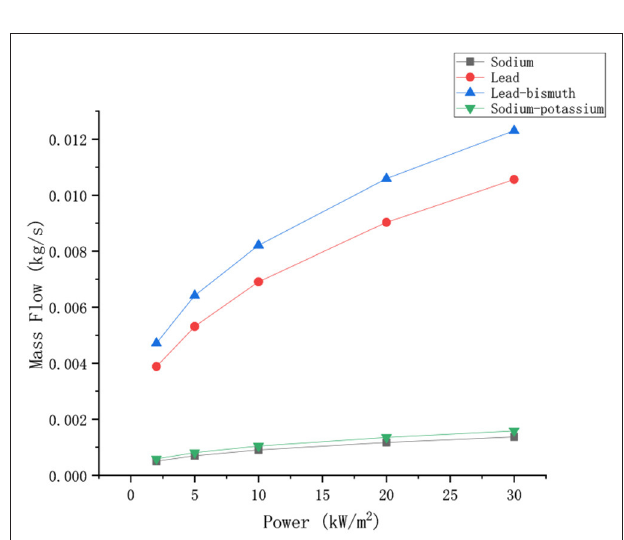
FIGURE 5 | Effect of heating power on mass flow of different liquid